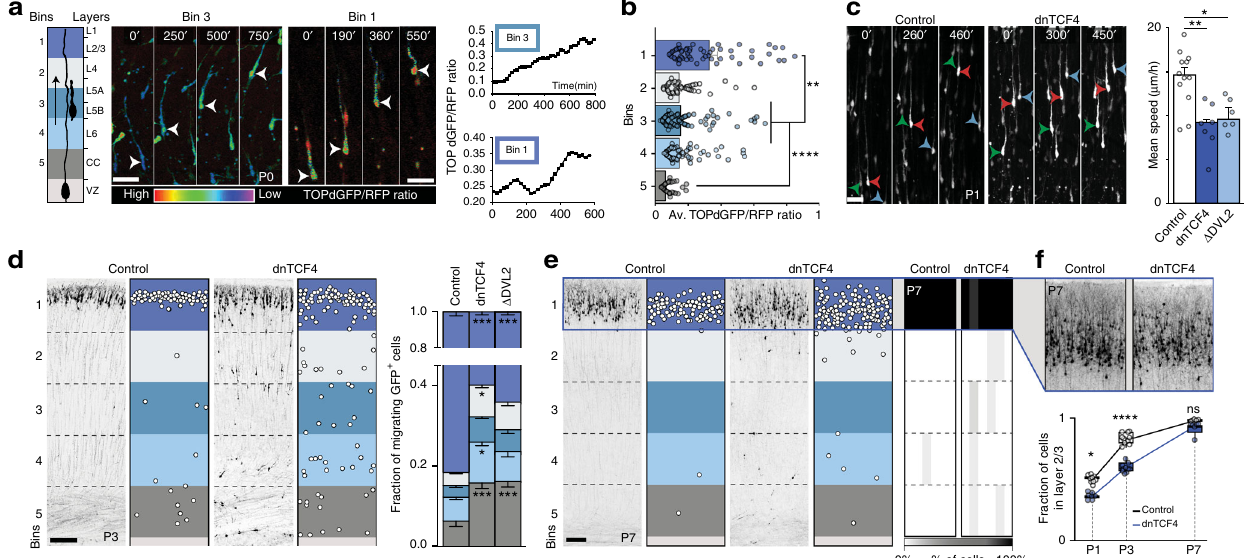
Fig. 1 In vivo downregulation of canonical Wnt/ß-catenin signaling reduces migration speed and alters radial distribution of layer 2/3 CPNs in the rat somatosensory cortex. a Single-cell confocal imaging of TOPdGFP/UBI-RFP electroporated cells in the cortical plate. The migration path was divided in fi ve equal bins corresponding to layers as illustrated. TOPdGFP/RFP intensity ratio shows dynamic Wnt-canonical signaling activity in neurons during radial migration at P0. The graphs represent the intensity ratio of the two illustrated cells over time. See also Supplementary Movie 1. b Averaged cellular ratios of TOPdGFP/RFP reveal increased Wnt-activity as cells approach the pial surface; n = 60, 47, 90, 65, and 38 cells, in bin 1, bin 2, bin 3, bin 4, and bin 5, respectively, Kruskal – Wallis. c Video time lapse images demonstrating that downregulation of canonical Wnt signaling (dnTCF4 and Δ DVL2) decreases speed of locomotion; quanti fi cation based on n = 13, 7, and 6 brains (Control, dnTCF4 and Δ DVL2, respectively), Mann – Whitney. See also Supplementary Movie 2. d Delayed dnTCF4-electroporated cells in P0 coronal sections. Fraction of migrating cells is shown in each bins; n = 10 brains per condition, two- way ANOVA. e By P7 delayed cells arrive to their layer. Heatmap of P7 cortical cell distribution at fi ve levels, color-coded columns represent n = 6 brains/ condition. f Comparable constitution of layer 2/3 in control and dnTCF4 brains at P7. The graph represent the proportion of cells arrived in the layer 2/3 at P1, P3, and P7 based on n = 9 and 7 brains at P1, n = 10 brains at P3 and n = 6 brains at P7 (Control, dnTCF4, respectively), Mann – Whitney. Graphs display mean ± s.e.m. * P < 0.05, ** P < 0.01, *** P < 0.001, **** P < 0.0001. Bars = 20 µ m ( a , c ), 50 µ m ( f ) and 100 µ m ( d , e ;